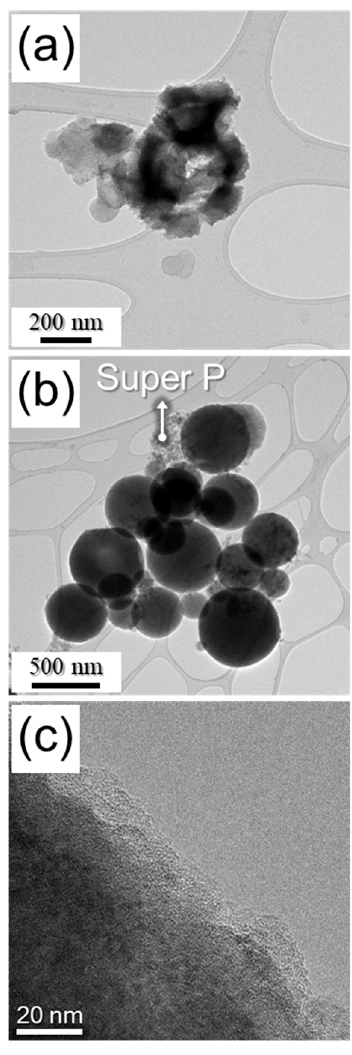
Figure 7. The morphologies of ( a ) bare MoO 3 powders and ( b , c ) MoO 3 /C composite microspheres obtained after 100 cycles at a constant current density of 1.0 A g − 1 .